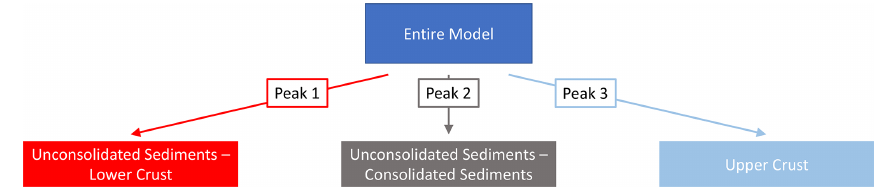
Figure 5. Schematic representation of the hierarchical global sensitivity